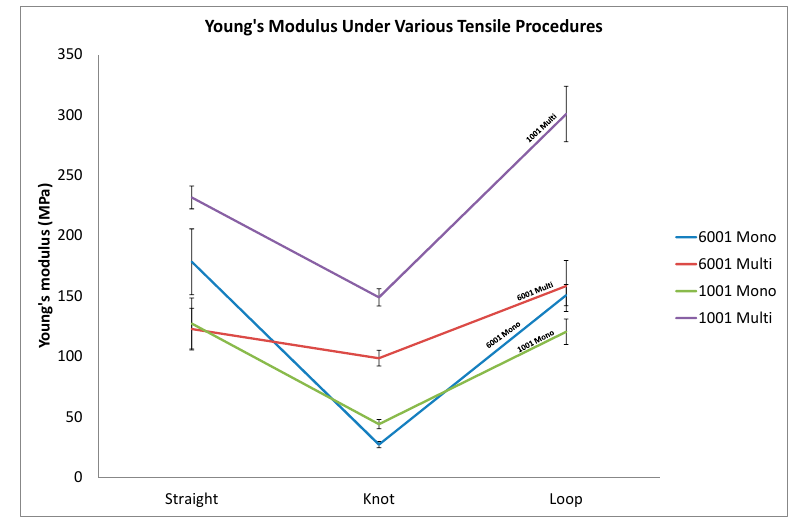
Figure 10. Young’s modulus from tensile analysis of the multifilament and monofilament fibres.